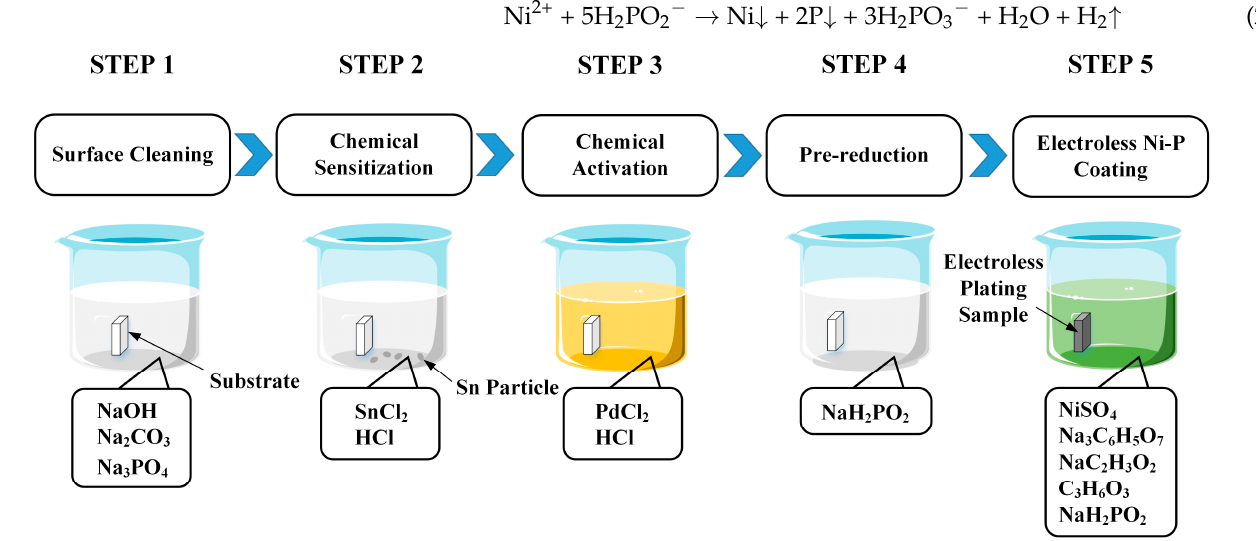
Figure 1. Process of electroless plating experiment. Table 1. Composition and Operating Conditions of Electroless Ni-P Coating Solution.